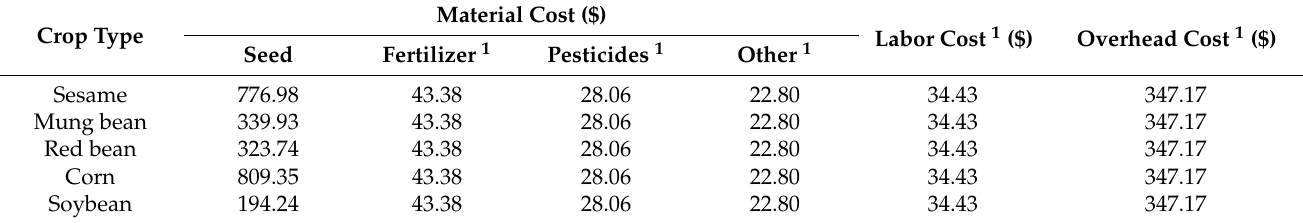
Table 3. Production costs of all five grain crops used in this